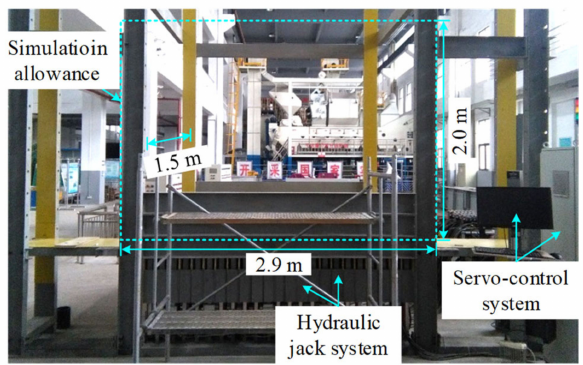
Figure 2. 3D non-destructive fluid-solid coupling test